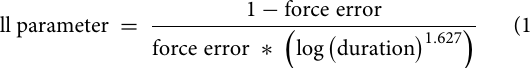
TABLE 1 Participant means and standard deviations for the control and exercise